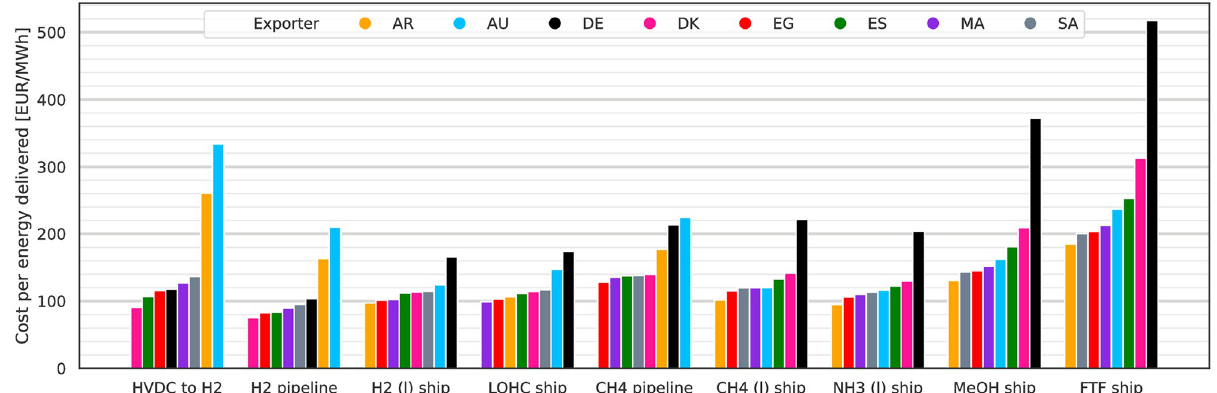
Fig 4. LCoE in 2030 assuming 10% p.a. WACC by ESC and exporter. LCoE are per MWh th delivered to DE. Lowest cost options are imports via HVDC with subsequent electrolysis in DE and H2 pipelines. For more complex and energy intensive ESCs on the right the order of preference is different compared to the static import options with imports from AR in all but one case being the